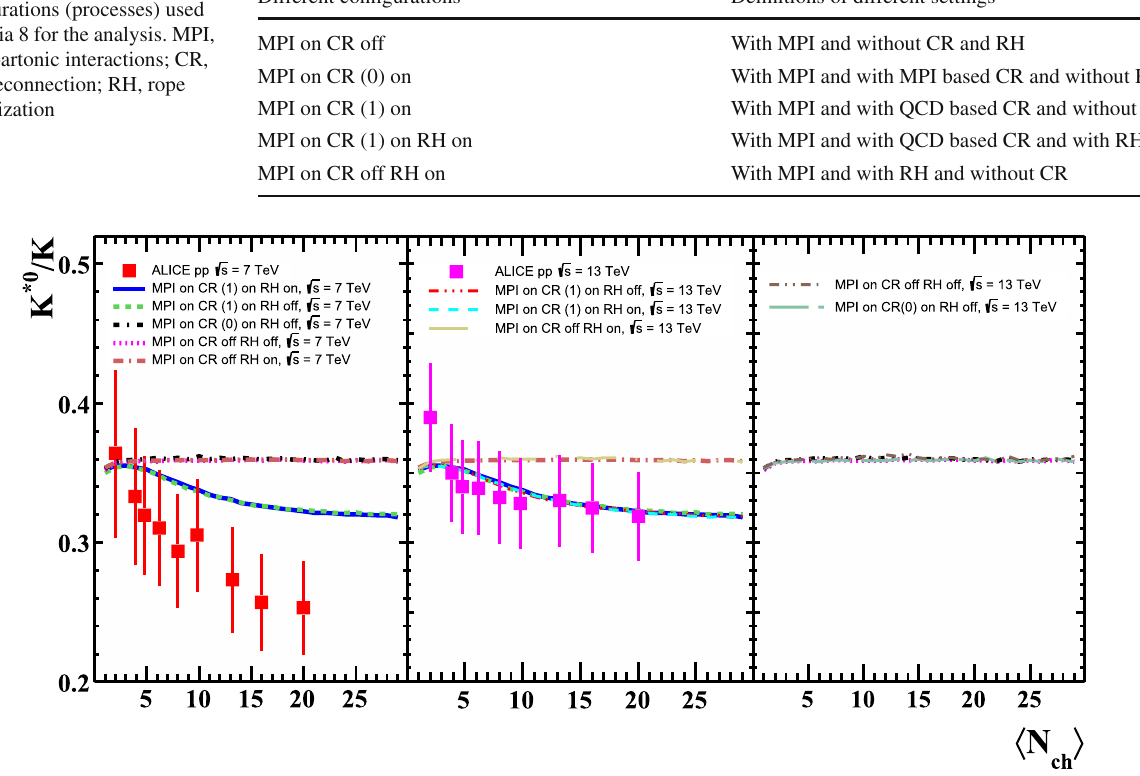
Fig. 1 p T -integrated ratio of K ∗ 0 / K as a function of < N ch > for p–p collisions. (Left panel) The ratios are compared for two different modes of color reconnections [CR-off, CR(0) and CR(1)] with (and √ s = 7 TeV. (Middle panel) The ratios without) RH in p–p collisions at √ s = 7 TeV and 13 TeV for CR-off, are compared for p–p collisions at